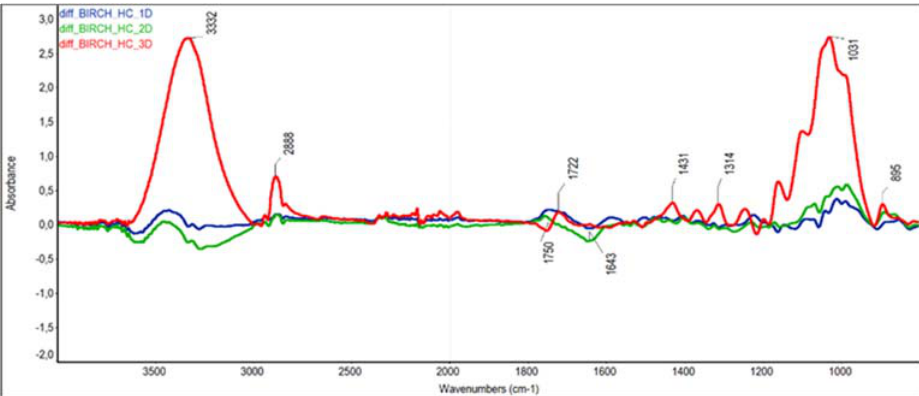
Figure 7. The absorption difference spectra of holocellulose.